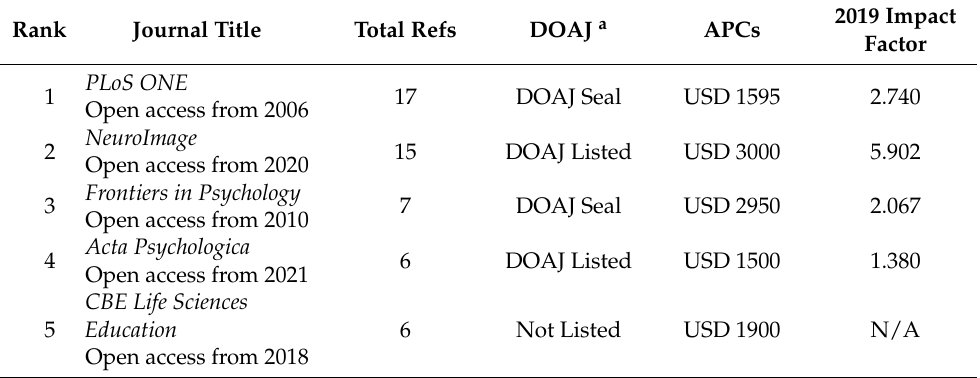
Table 4. Top cited OA